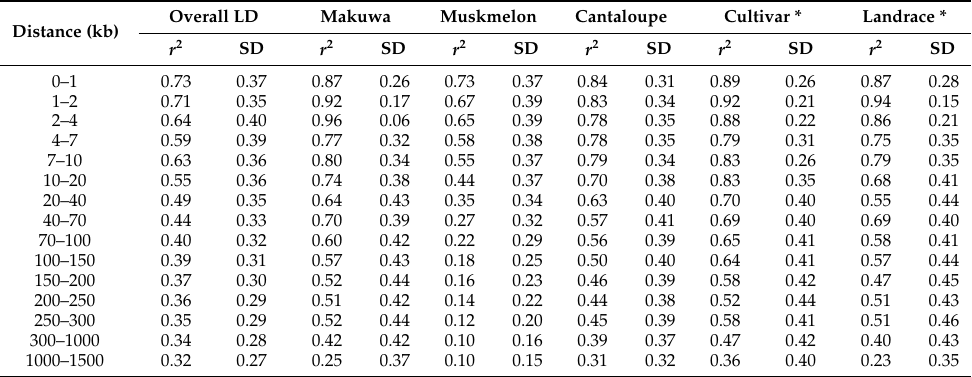
Figure 2. Linkage disequilibrium ( r 2 ) versus physical distance (kb) in the whole melon accessions col- lection. Genome-wide pattern of decay of linkage disequilibrium (LD) up to 1500 kb pairwise distances. Table 4. Mean linkage disequilibrium (LD) values according to distance (kb). The LD was calculated separately for the makuwa, muskmelon, and cantaloupe groups defined by the discriminant analysis of principal components